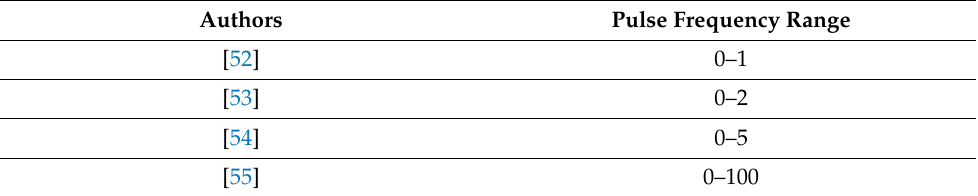
Table 3. The different pulse frequency ranges implemented by the researchers for the Standard BA modification.